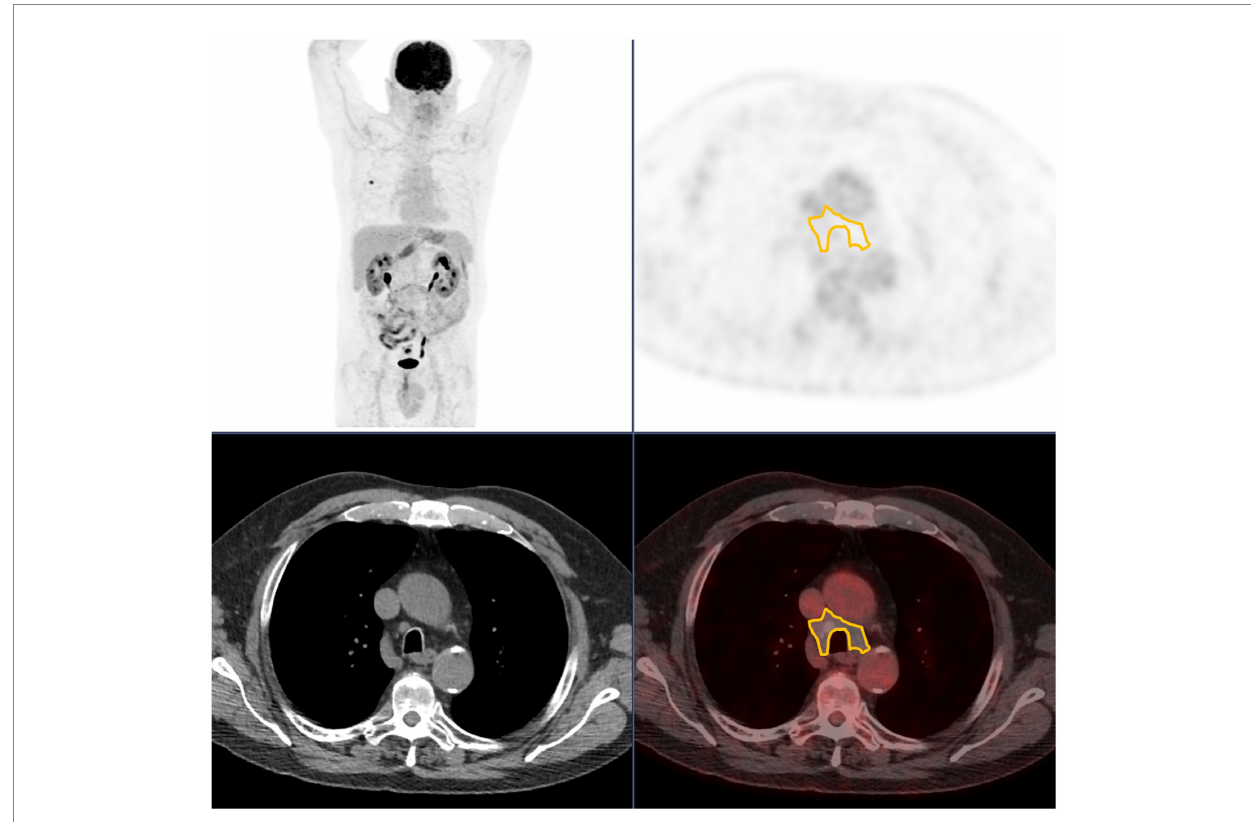
FIGURE 1 Region of interest used when no pathological lymph node uptake is seen, encompassing 4R and 4L station. From top to bottom and from left to right: maximum intensity projection; axial PET; axial CT; axial fused